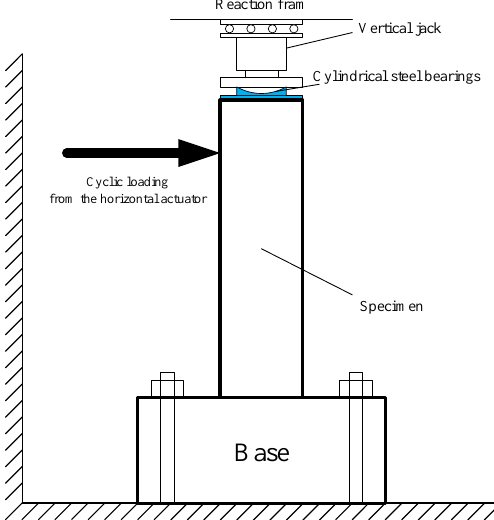
Figure 2. The configuration of the experiment.